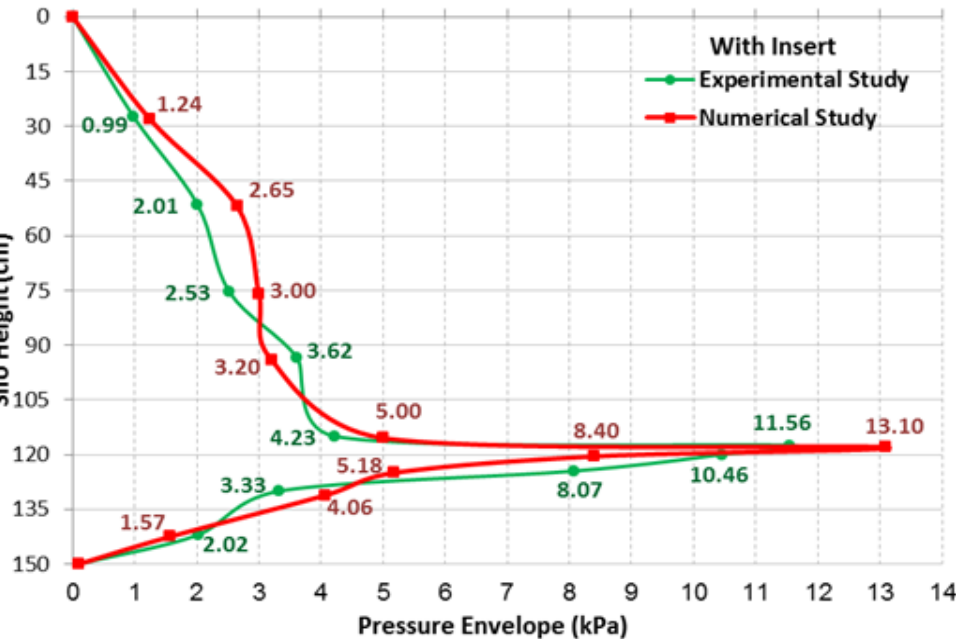
Figure 21: The comparison is between the pressure produced by the numerical study and the pressure registered by the experimental study with insert